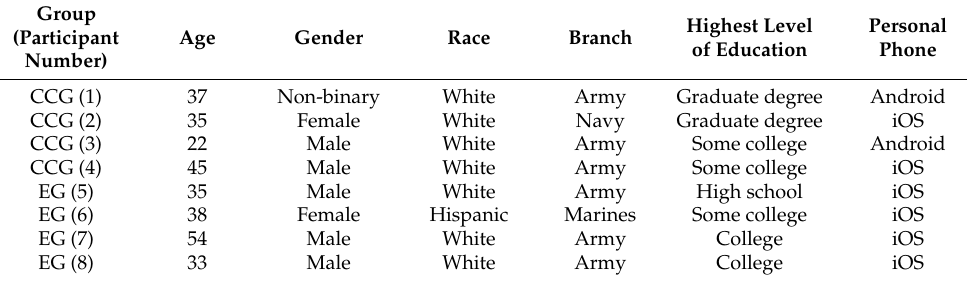
Table 3. Participant Demographics.